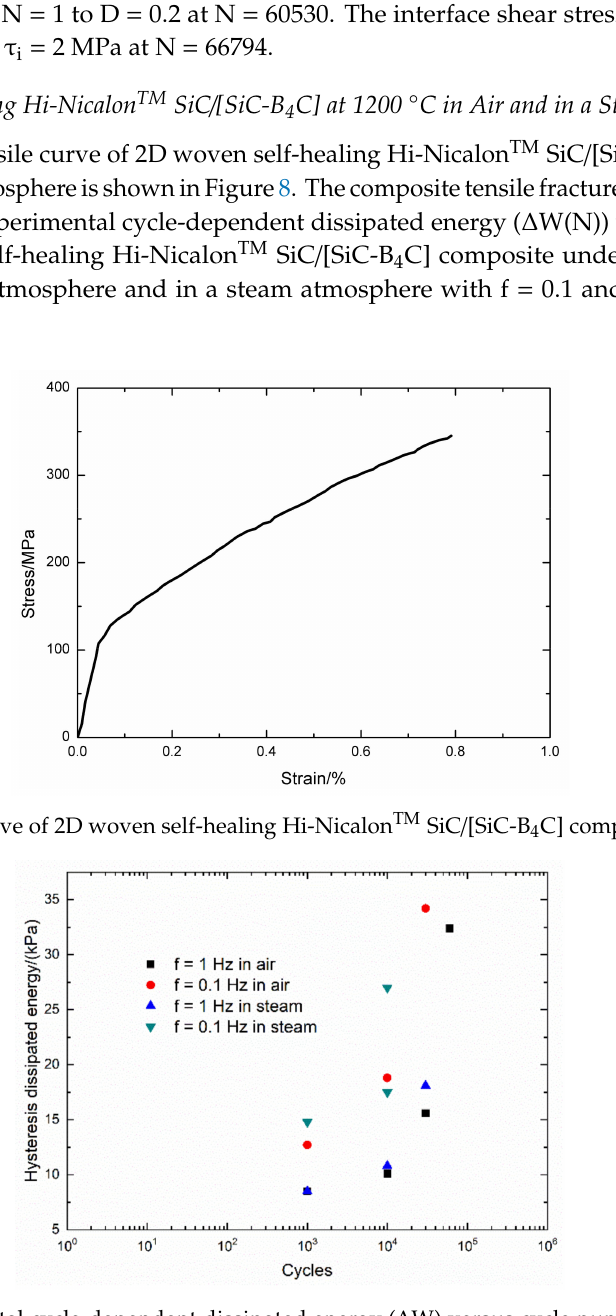
Figure 9. Experimental cycle-dependent dissipated energy ( ∆ W) versus cycle number curves of 2D woven self-healing Hi-Nicalon TM SiC / [SiC-B 4 C] composite under σ max = 140 MPa at 1200 ◦ C in air and in steam